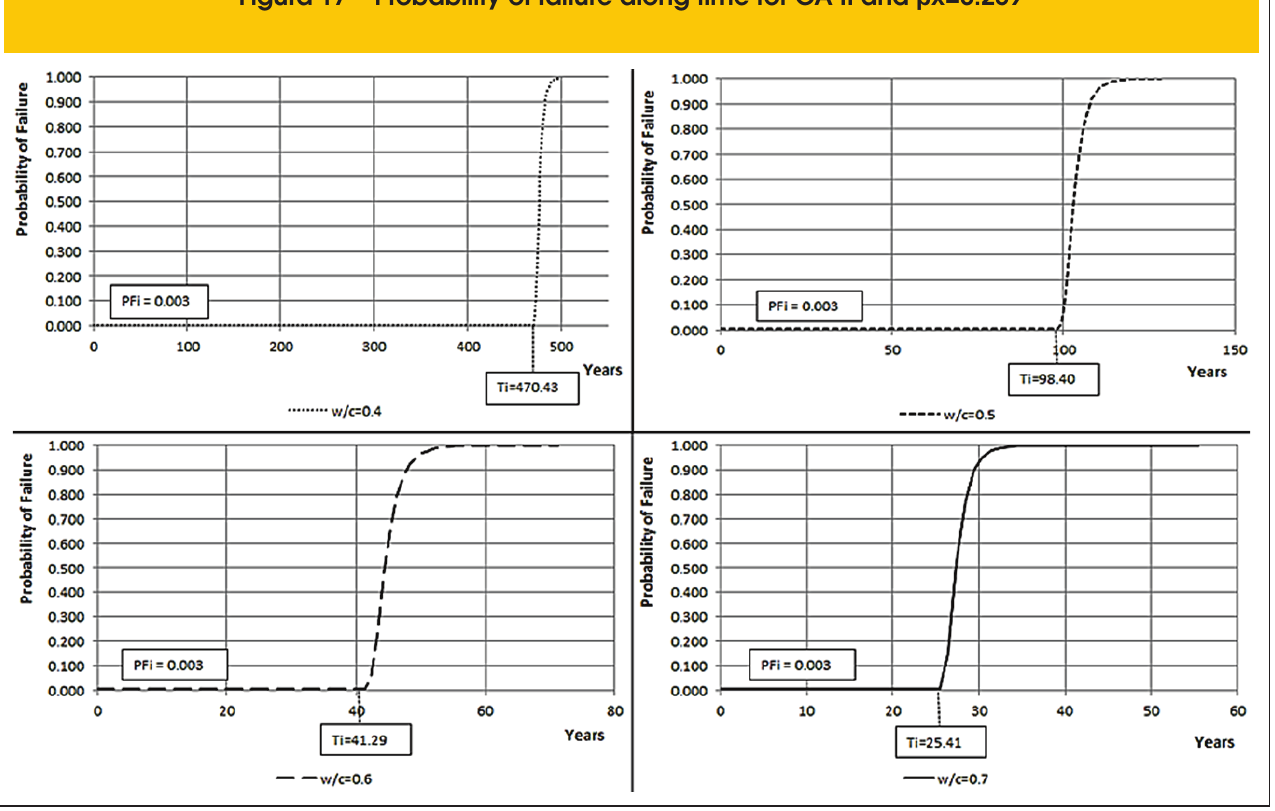
Figura 17 – Probability of failure along time for CA II and β